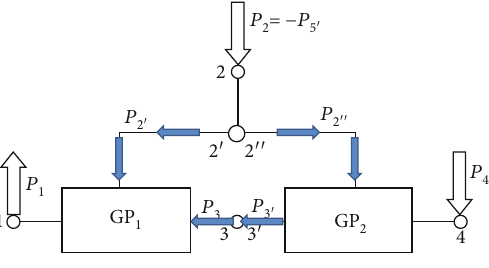
> ω > ω > 0 > ω 4 1 2 3 .